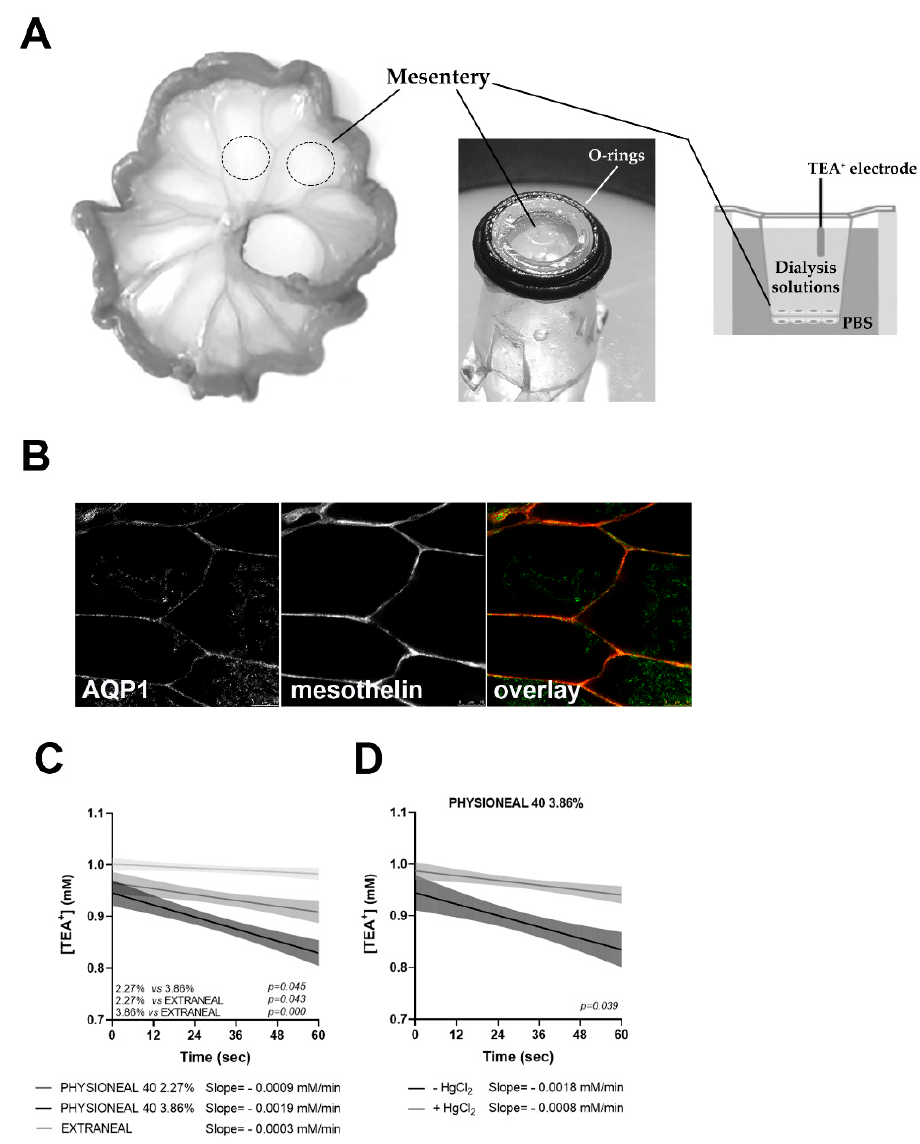
Figure 5. Transepithelial water transport in the mouse mesentery and role of AQP1. ( A ) Schematic representation of isolation of mouse mesentery patches for measurements of the osmotically induced transcellular water flux with TEA + -sensitive microelectrodes; ( B ) Characterization of mouse mesentery by immunofluorescence analysis: in confocal sections AQP1 and mesothelin co-localized at the plasma membrane. bar = 10 µ m; ( C ) Osmotically induced transepithelial water transport in mouse mesentery in response to Physioneal 40 2.27%, Physioneal 40 3.86% and Extraneal. Slopes (solid lines) and 95% confidence interval (shaded areas, CI) for the regression of [TEA + ] calculated during the first 60 s of the response. Statistical analysis of the differences between slopes is reported within each panel. The value of the slopes is reported on the bottom of each panel; (Physioneal 2.27%: n = 3; Physioneal 3.86%: n = 5; Extraneal: n = 3); ( D ) Osmotically induced transepithelial water transport in mouse mesentery in response to Physioneal 40 3.86% , in the presence or in the absence of HgCl 2 . The value of the slopes is reported on the bottom of each panel (Physioneal 3.86% without HgCl 2 : n = 3; Physioneal 3.86% with HgCl 2 : n = 3).